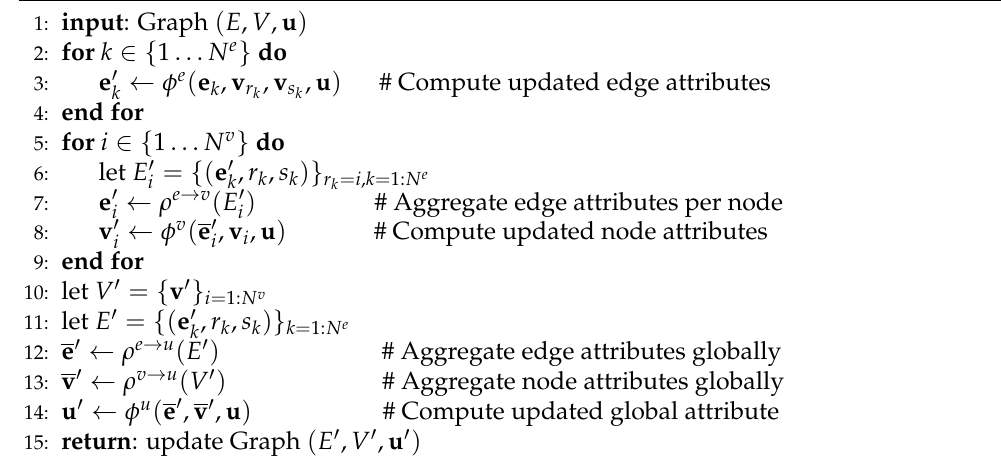
Algorithm 1 Computation steps of graph network